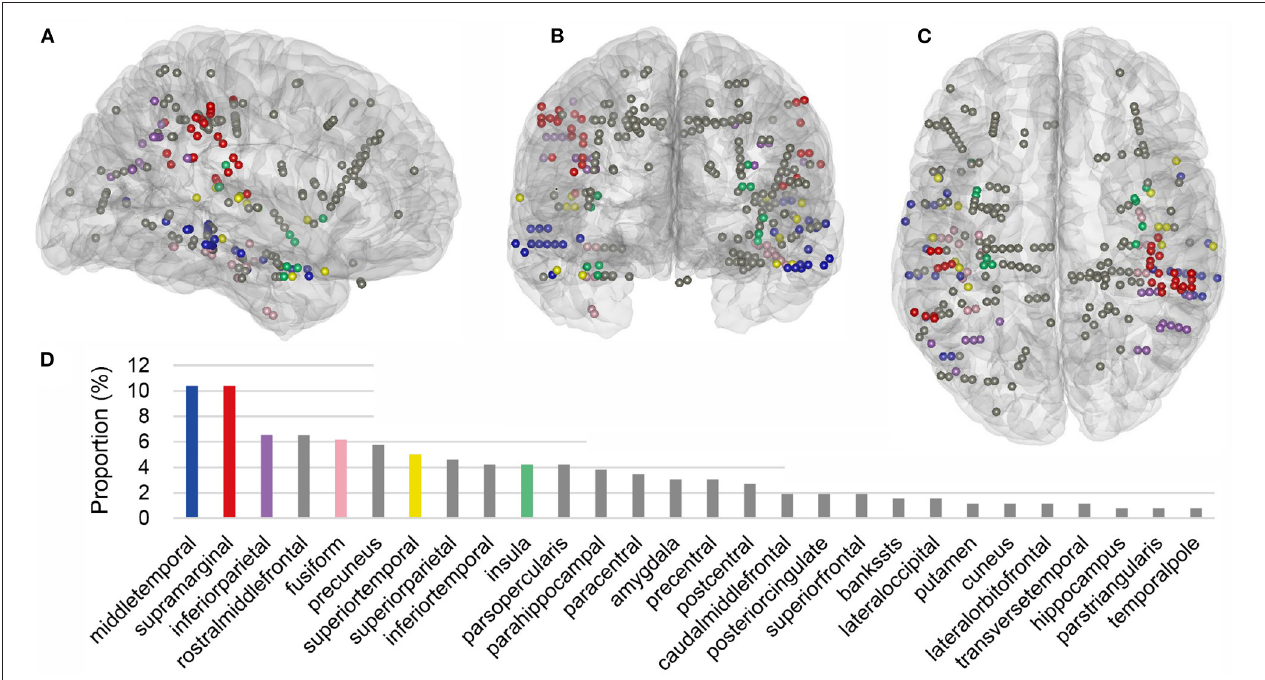
FIGURE 8 | Cross-modal contacts projected on the three-dimensional standard Montreal Neurological Institute (MNI) brain model. (A–C) Show the brain model and cross-modal contacts in a sagittal, coronal, and transverse view, respectively. These contacts were all from cross-modal regions in Figure 7 , and they provided informative features to both modalities. (D) Shows the proportion of single-region contacts in all cross-modal contacts. In brief, the number of total cross-modal contacts from all subjects was added, and the number of cross-modal contacts in each region from different subjects was divided by the total, generating the proportion. Common cross-modal regions in at least 67% of subjects were highlighted with different colors, and other regions were displayed with gray.